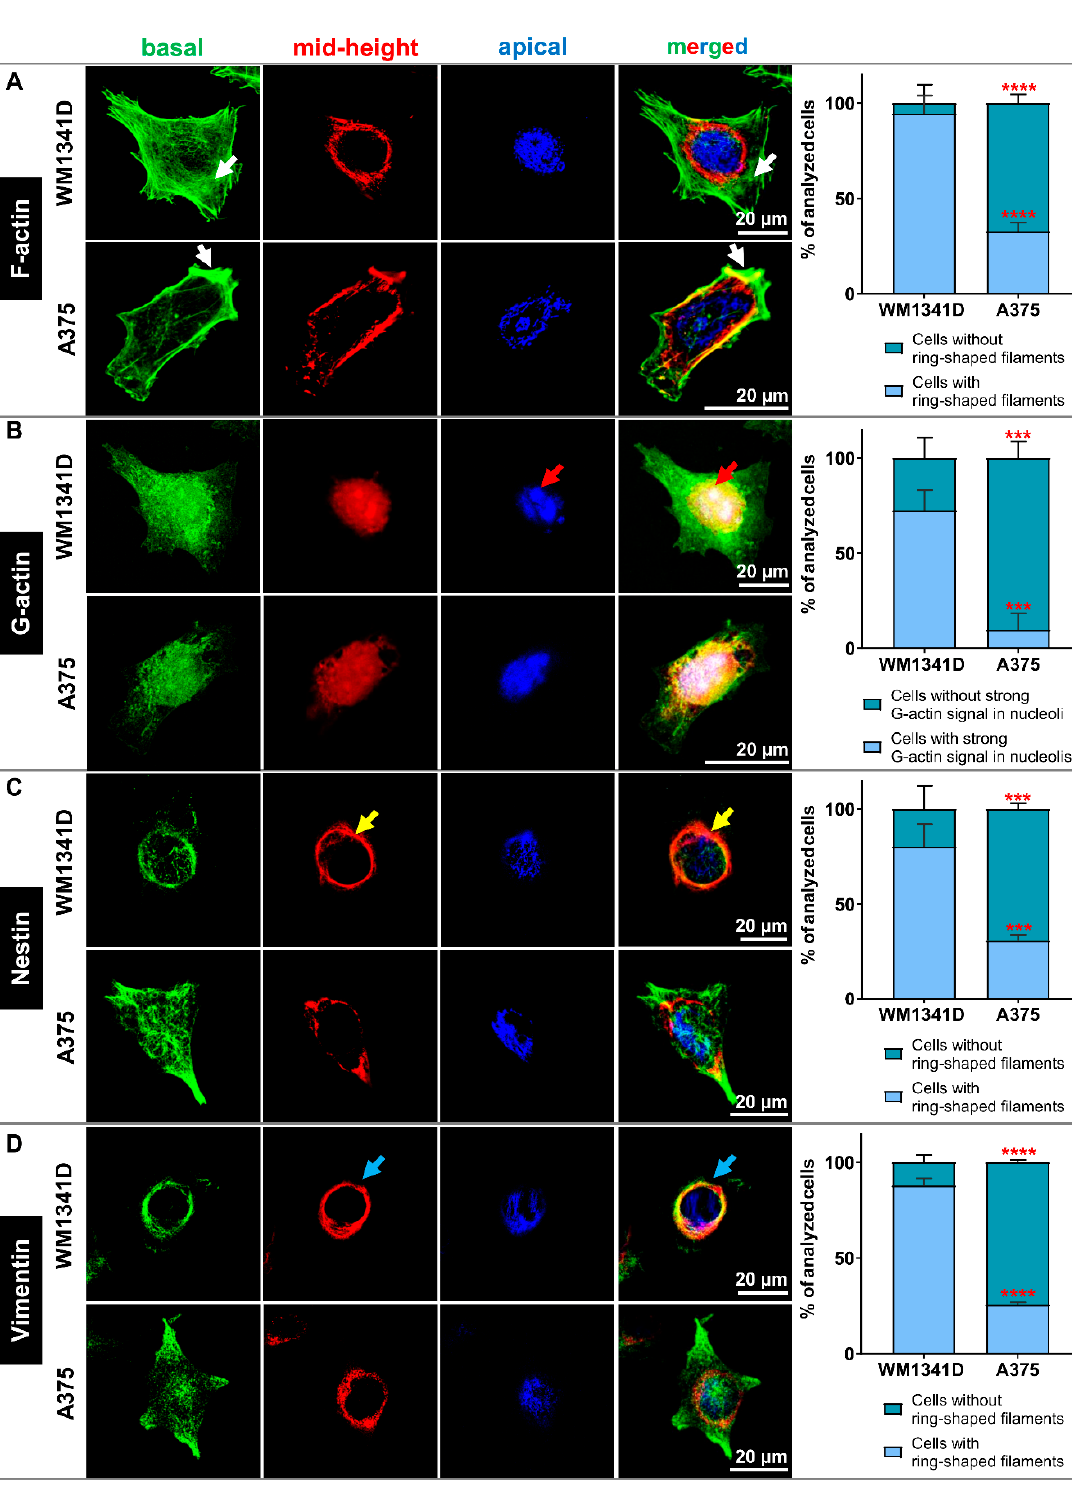
Figure 5. The actin cytoskeleton and organization of Nestin and Vimentin filaments in WM1341D and A375 cells. ( A – D ) Immunocytochemical stainings to detect selected cytoskeleton components in WM1341D and A375 cells. The confocal microphotographs pictures for each cell were captured at three focal planes: cell contact area to the substratum (basal— green), a cross-section of the cell nucleus (mid-height—red), and nucleus apical outer surface (apical—blue). Finally, the photos were merged into a single image. ( A ) Detection of filamentous actin (F-actin). White arrows indicate stress fibers. ( B ) Visualization of monomeric actin (G-actin). Red arrows point at the denser aggregation of G-actin in nucleoli. ( C ) Detection of subcellular localization of Nestin. Yellow arrows indicate a ring-shaped localization around the nucleus. ( D ) Immunocytochemical staining to detect Vimentin. Blue arrows indicate a ring-shaped structure around the nucleus. Sep- arated microphotographs with additional F-actin and cell nucleus visualization are presented in Supplementary Figures